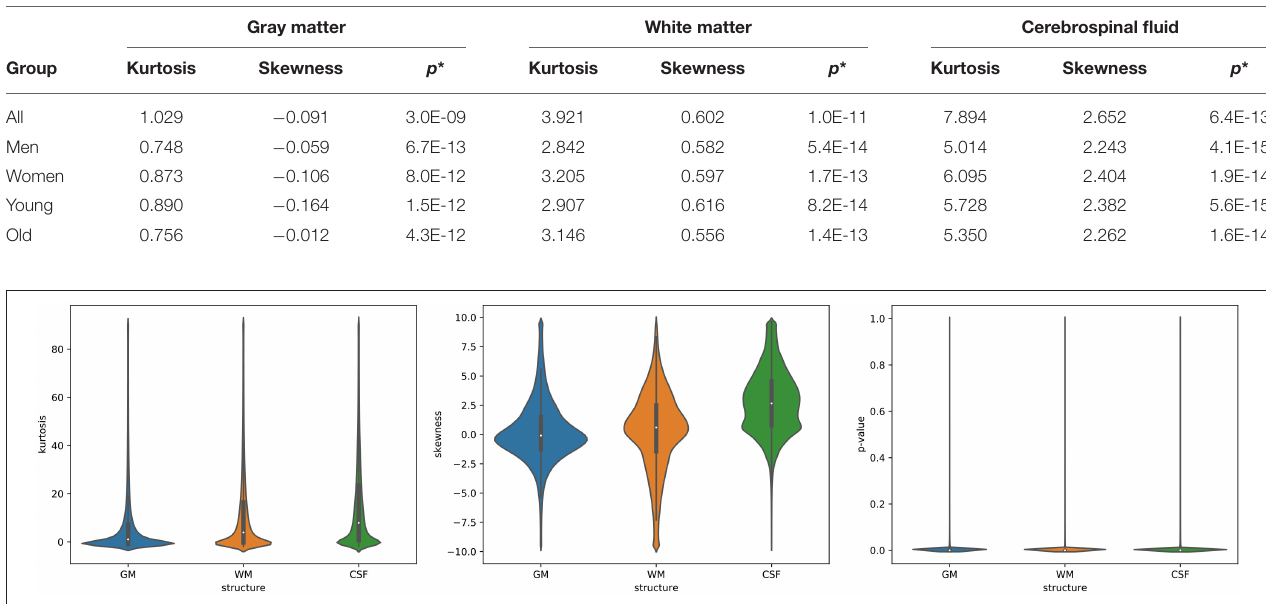
TABLE 2 | The medians of the Kurtosis, Skewness, and Shapiro-Wilk test p -values (p*) for GM, WM, and CSF (in columns) for the studied groups (All, Men, Women, Young, and Old). Gray matter White matter